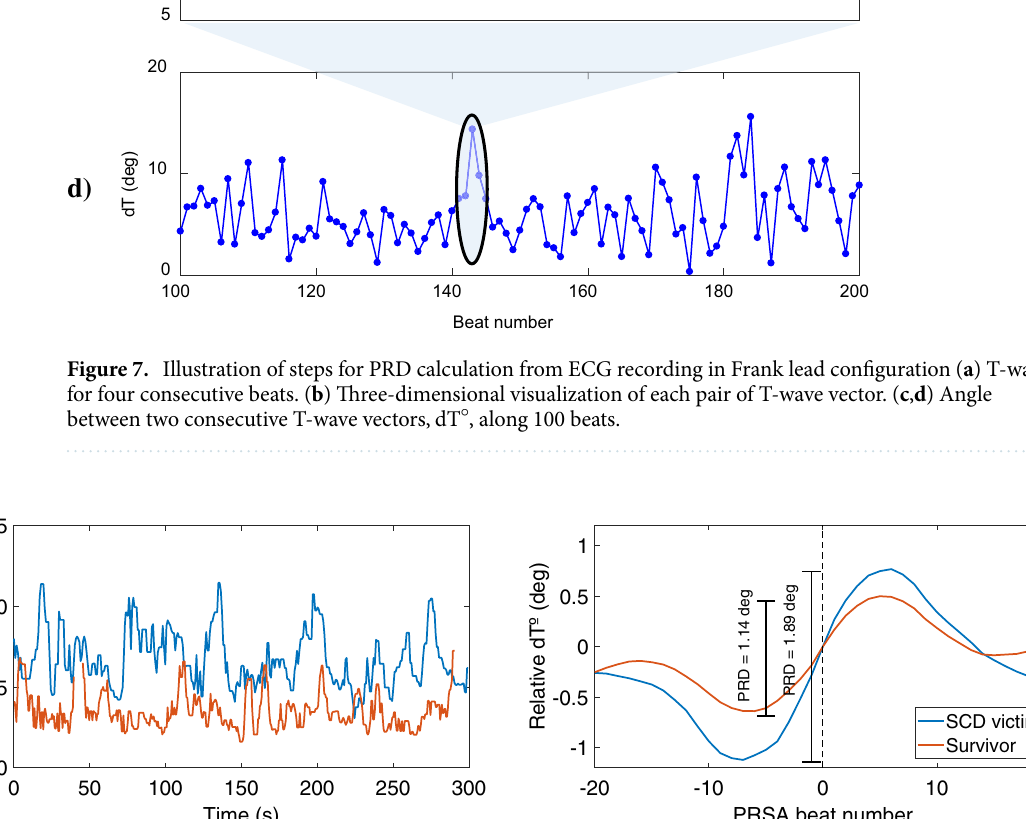
Figure 8. dT series along 300 s (left panel) and PRSA curve (right panel), where anchor beats were set to 0 from a SCD victim and a